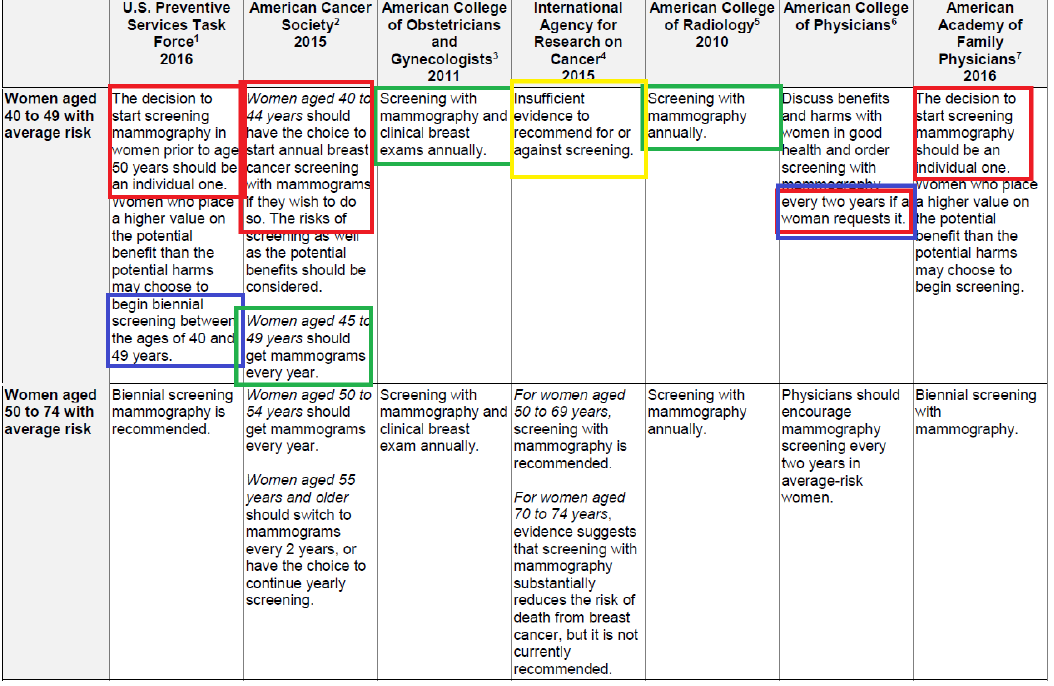
Figure 1. Note the contradictory recommendations in green and blue boxes. The colors in the table come from [6], but the original table comes from the CDC [3]. Only a part of the table is reproduced